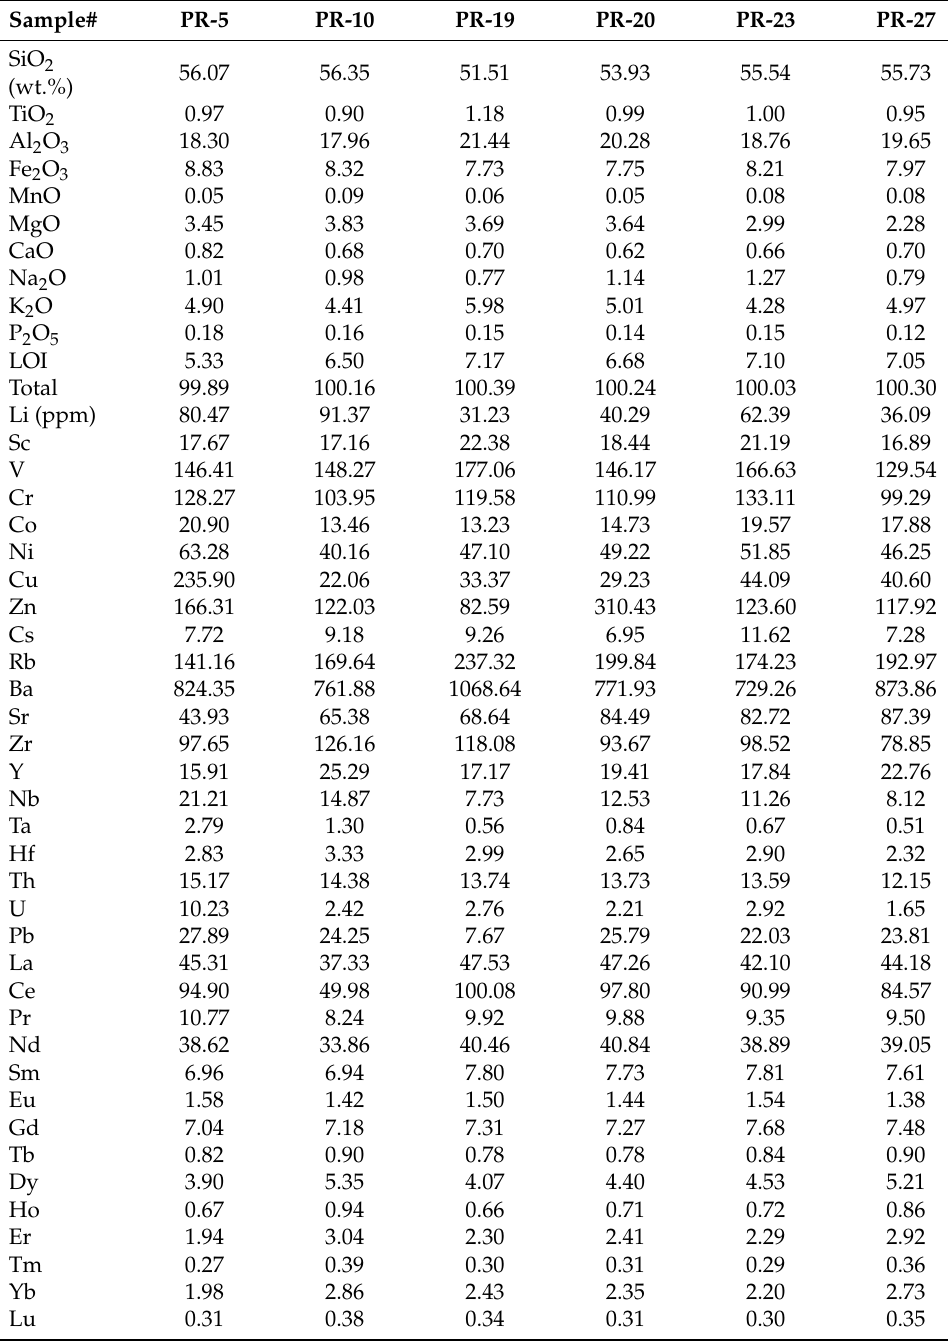
Table 3. Chemical composition of Paleozoic lavas from the Priorat DOQ region